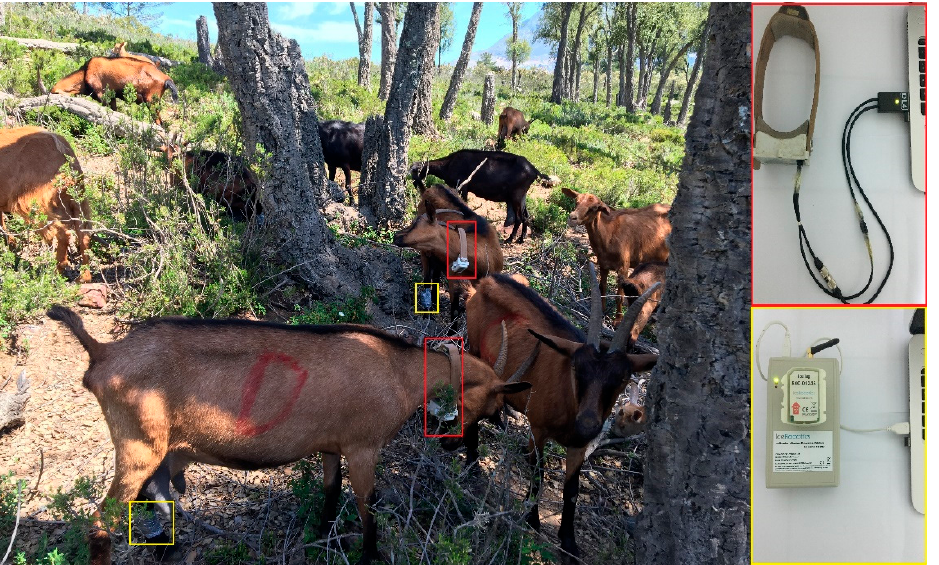
Figure 1. Alpine goat equipped with a GPS collar on the neck (red) and leg sensor positioned on the rear left leg (yellow) in the studied forest rangeland of Northern Morocco.